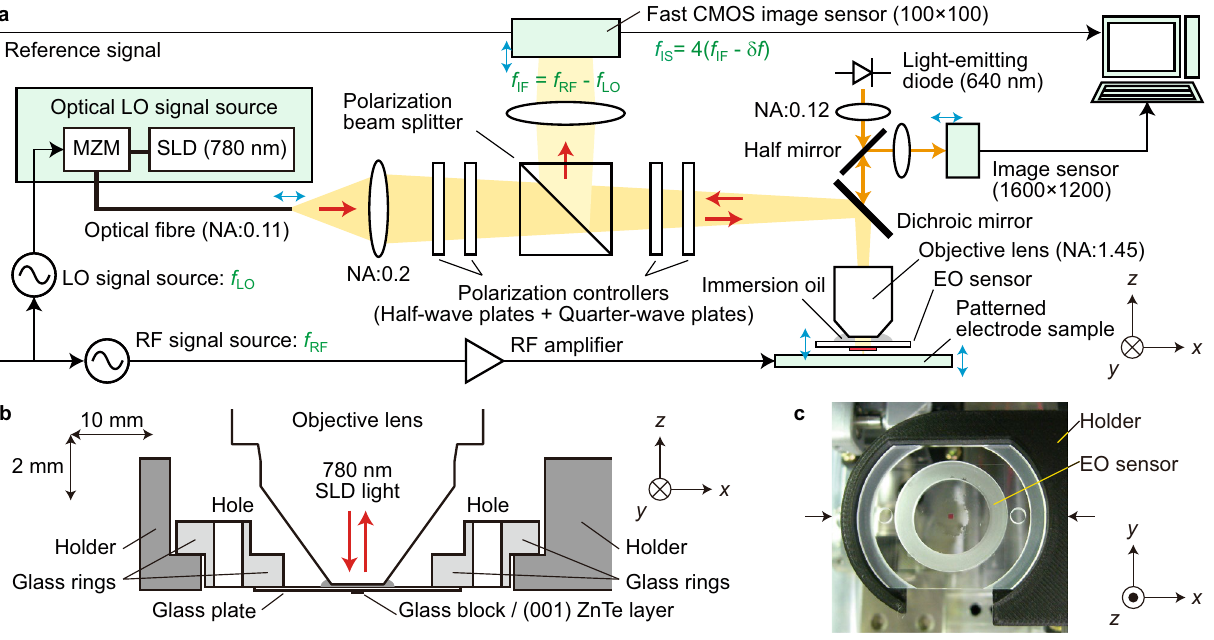
Figure 1. LEI system. The optics include an oil-immersion objective lens and a thin film EO sensor. ( a ) Schematic drawing of the present LEI system. Blue arrows indicate fine positioners. Frequencies f RF , f LO , f IF , f IS , and δ f are explained in the main text and the “Methods” section. ( b ) Centrally sectioned drawing of the oil-immersion objective lens and EO sensor. The x and z directions have anisotropic magnifications. ( c ) Top- view photograph of the EO sensor set in its holder. CMOS complementary metal–oxide–semiconductor, IF intermediate frequency, LO local oscillator, MZM Mach Zehnder optical modulator, NA numerical aperture, RF radio frequency, SLD super-luminescent